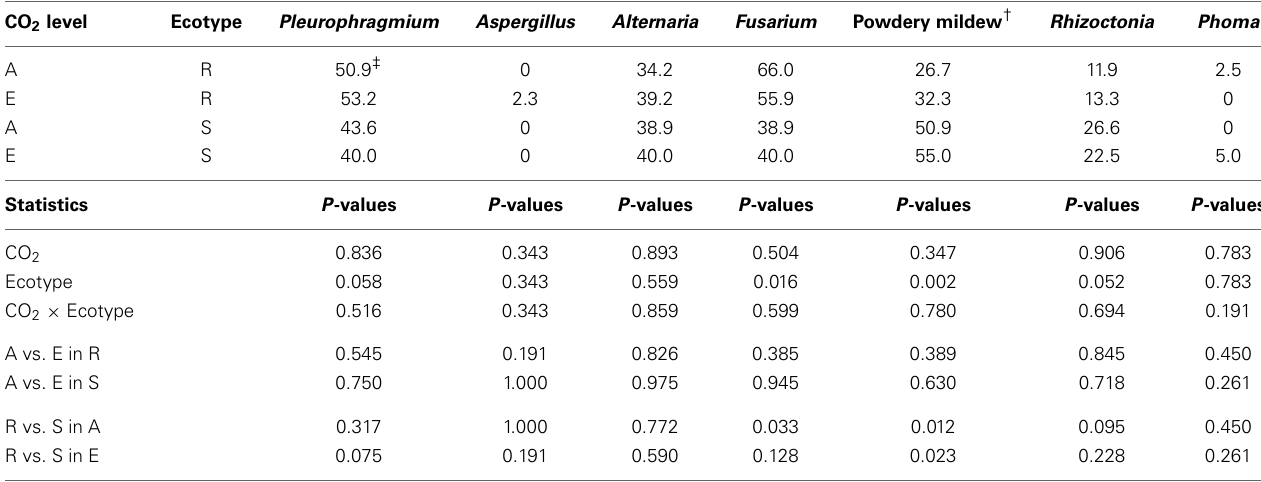
Table 2 | Effects of atmospheric CO 2 concentration (ambient, A = 375 µ mol mol − 1 ; elevated, E = ambient + 200 µ mol mol − 1 ) on frequency of fungi associated with two ecotypes (R = Resistant; S = Susceptible to glyphosate) of common ragweed leaves.